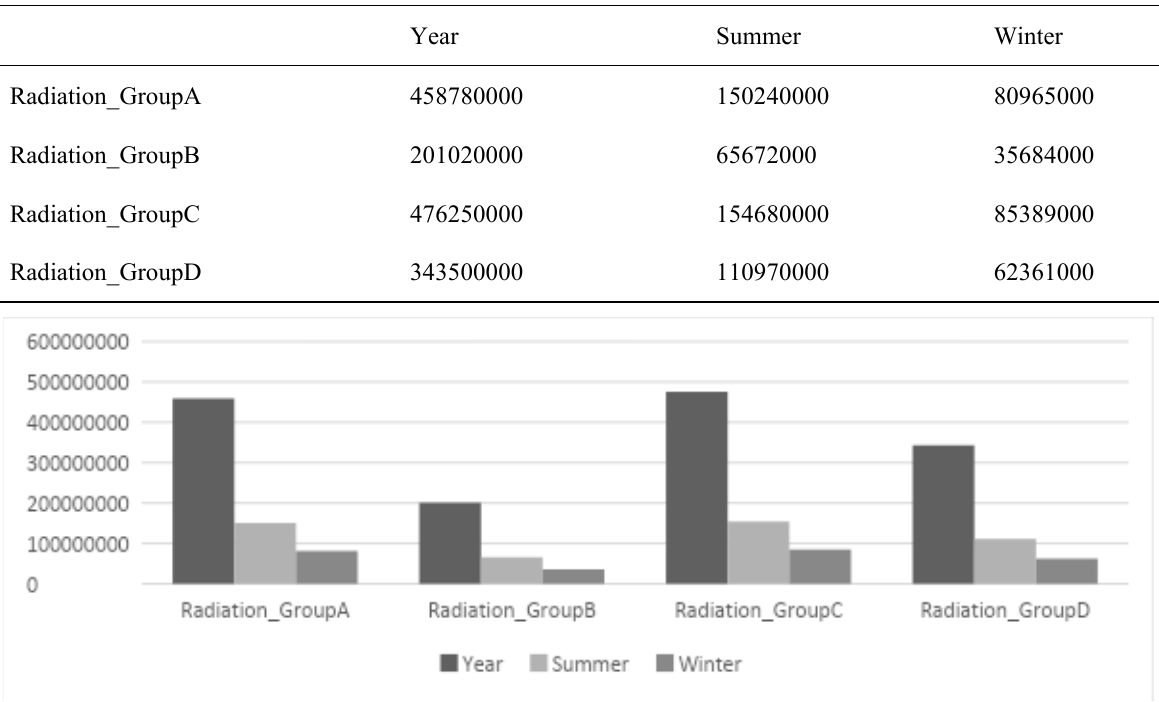
Table 6. Investigation of the amount of radiation in the four sub-neighborhoods of Farhangian, phase 1 by year and season (summer and winter)